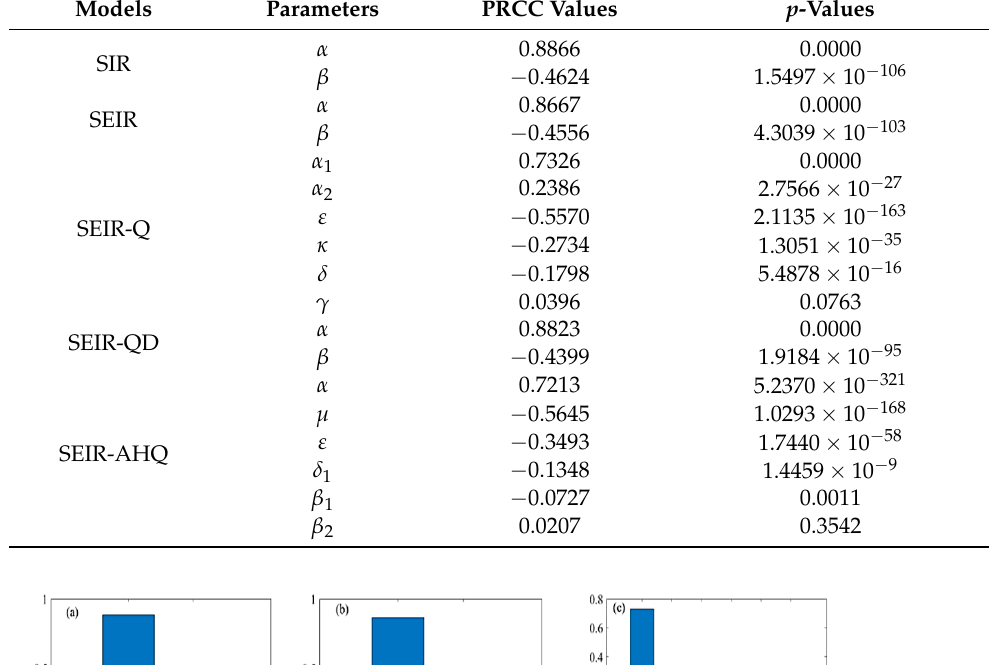
Table 1. The PRRC values of R 0 with corresponding P -values.